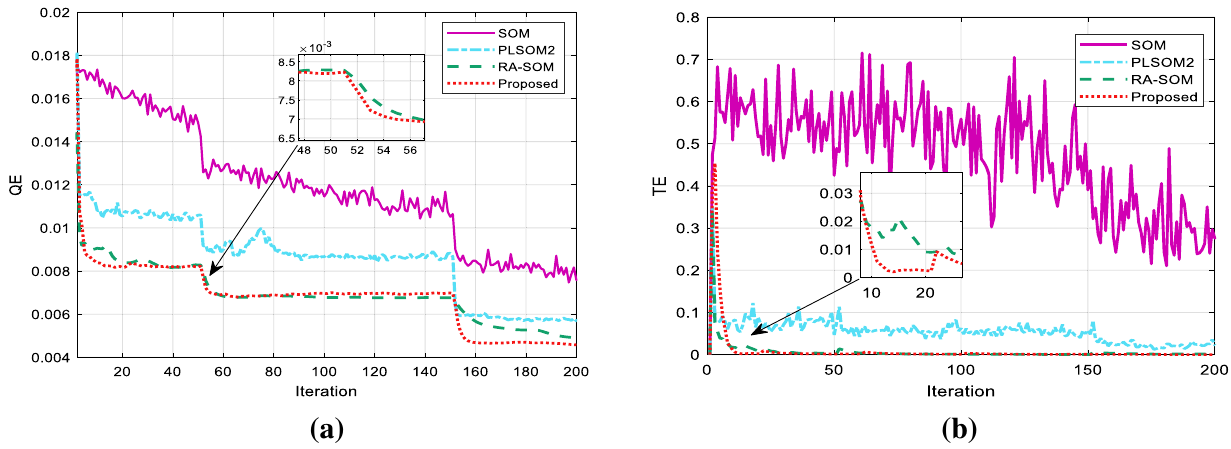
Fig. 2 Comparative analysis of the conventional SOM, PLSOM2, RA-SOM and proposed VLR-SOM algorithms with 200 iterations in terms of a QE, and b